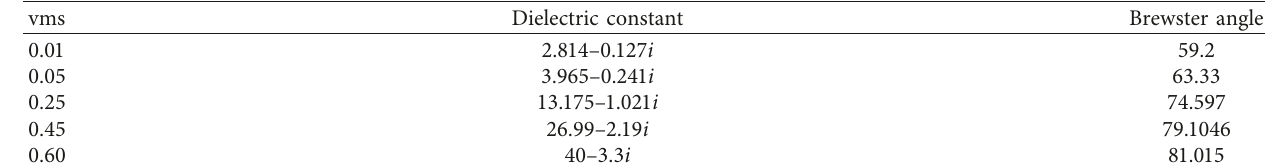
Table 1: Dielectric constants and the Brewster angles for different